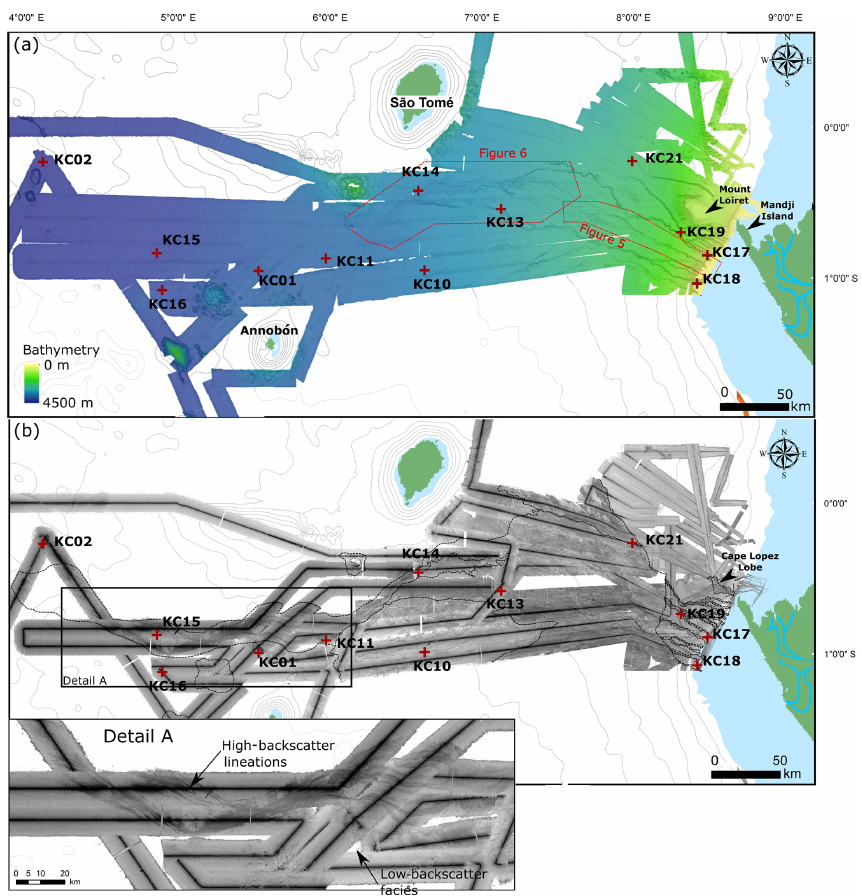
Figure 2. (a) Detailed bathymetric map of the Ogooue Fan, based on the multibeam echosounder data of the Optic Congo2005 and MO- COSED2010 surveys. (b) Acoustic imagery of the Ogooue Fan (high backscatter: dark tones; low backscatter: light tones). Detail A: close-up of the deepest part of the Ogooue Fan. Red crosses: location of the studied